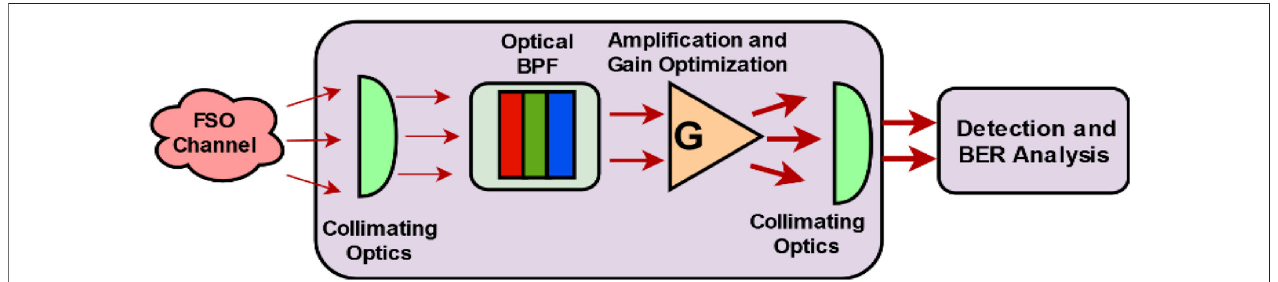
FIGURE 4 | Block diagram of an EDFA optical ampli fi